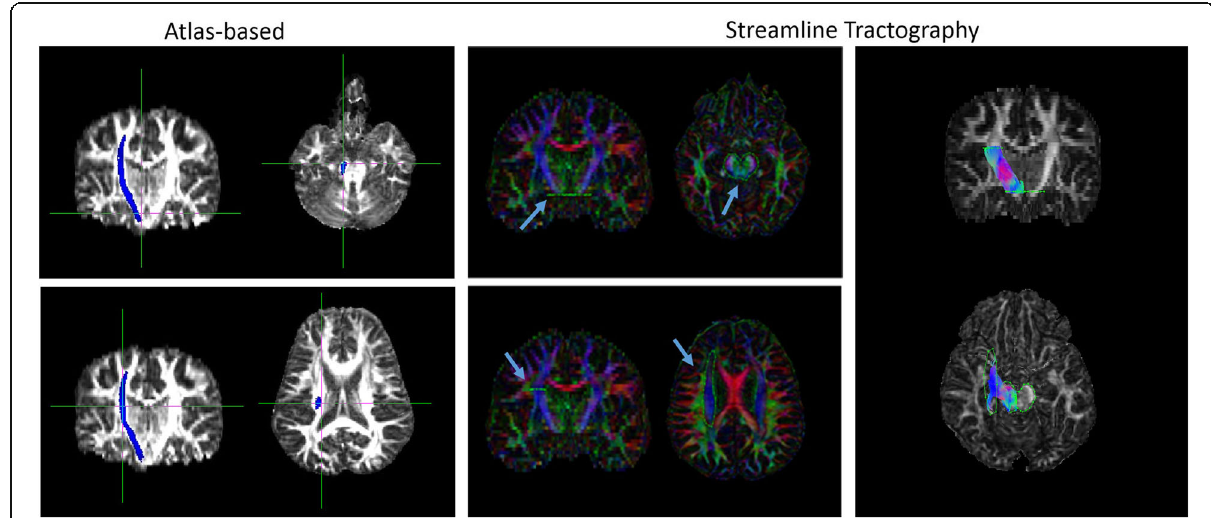
Fig. 2 Example of regions of interest used for the atlas-based (FMRIB software library [FSL] software) and streamline tractography (ExploreDTI software) approach. The corticospinal-tracts were defined for the FSL software automatically from the Johns Hopkins University white-matter template and for the ExploreDTI software manually between the superior corona radiata and the cerebral peduncles. The corticospinal-tract is marked in blue (with a blue arrow), respectively, for both the atlas-based and streamline tractography